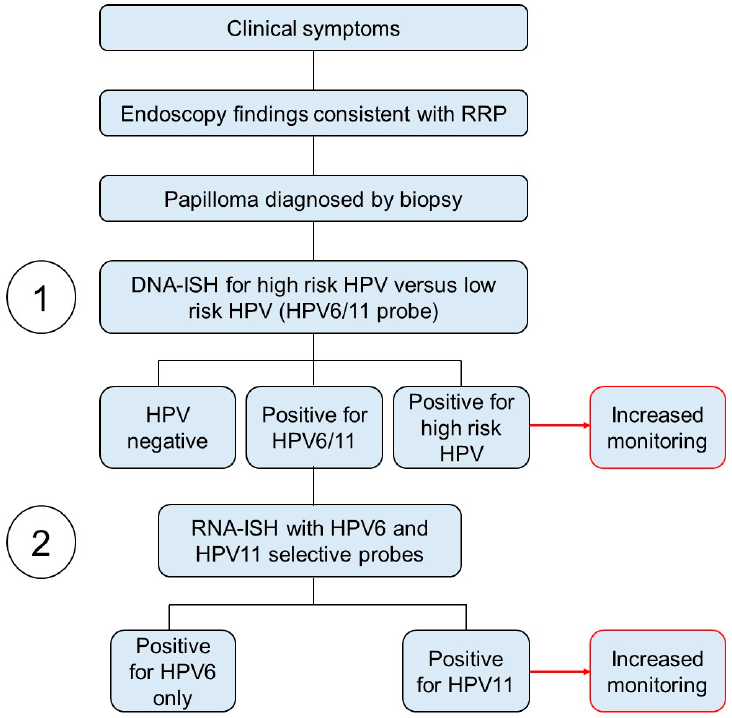
Figure 5. Proposed pipeline for screening HPV11. Clinical symptoms determine the need for endoscopy with biopsy being performed when masses are visualized. Pathologic diagnosis of papilloma results in routine clinical testing in most centers to determine low-risk versus high-risk HPV status (Step 1). A recommendation is proposed to supplement this initial step by testing those biopsies positive for low-risk HPV using HPV strain-selective probes (Step 2) in order to identify HPV11 positive patients that should be more aggressively monitored for disease progression and need for treatment intervention (emphasized in red).